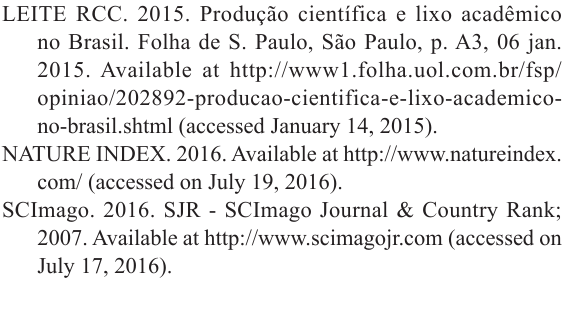
Figure S1 - Number of citable papers* published by Brazilian scientist.